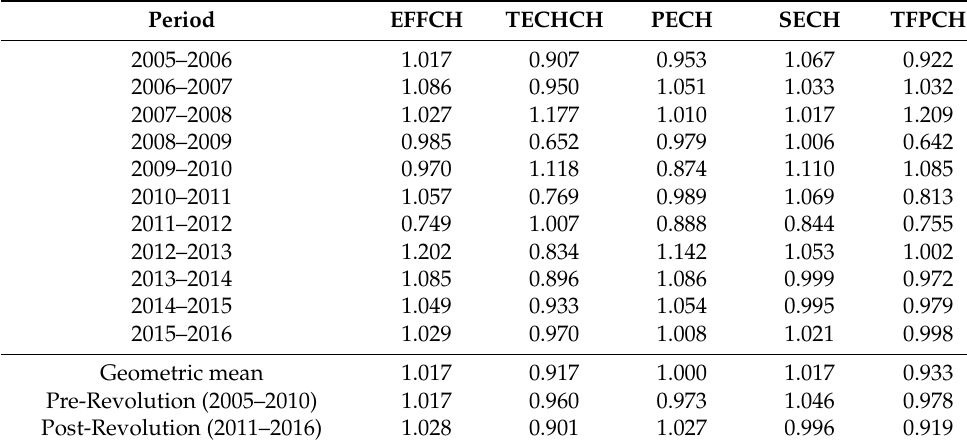
Table 8. Total factor productivity index and its components by